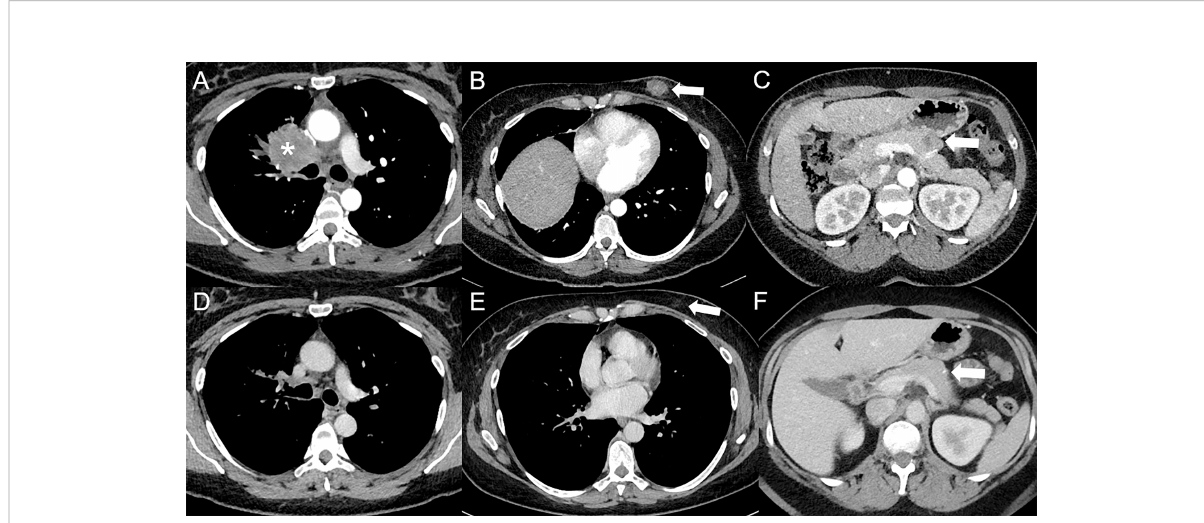
FIGURE 1 Complete response following immunotherapy in a 41-year-old female diagnosed in February 2016 with stage IV poorly differentiated lung adenocarcinoma in right upper lobe [asterisk *, (A) ], with hypodense subcutaneous (arrow, (B) ), and pancreatic [arrow, (C) ] metastases visible on baseline contrast-enhanced CT at the arterial phase (A – C) , treated with durvalumab (anti-PD-L1) and tremelimumab (anti-CTLA-4), followed by durvalumab maintenance. Since May 2017, a complete response was obtained. In April 2022, a complete response was still observed at the primary tumor (D) and subcutaneous [arrow, (E) ] sites, whereas only a squealer calci fi cation [arrow, (F) ] can be seen at the pancreatic site on contrast-enhanced CT at the portal venous phase (D – F)